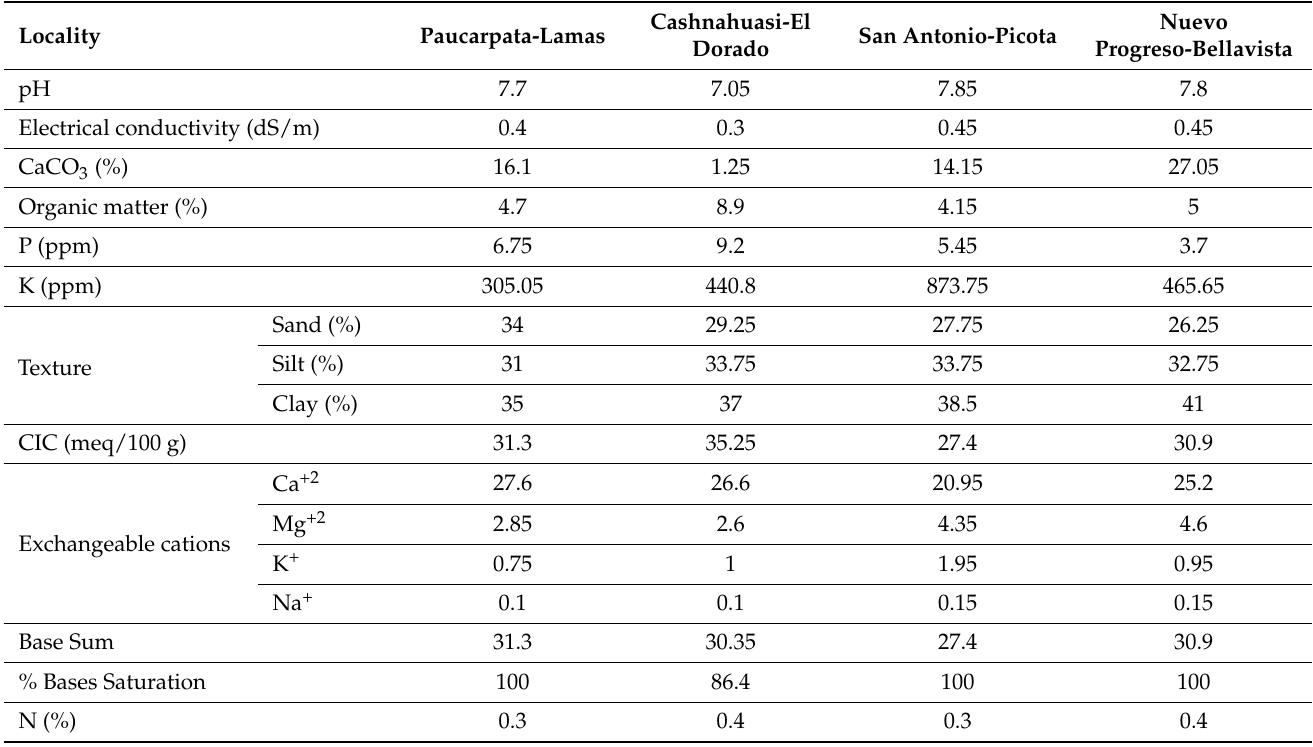
Table A2. Soil properties and average physicochemical parameters of the soil of plantations producing sacha inchi in four localities of the San Mart í n region.